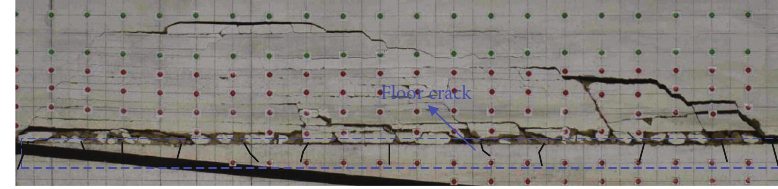
Figure 10: Schematic diagram of fl oor crack development due to the mining in fl